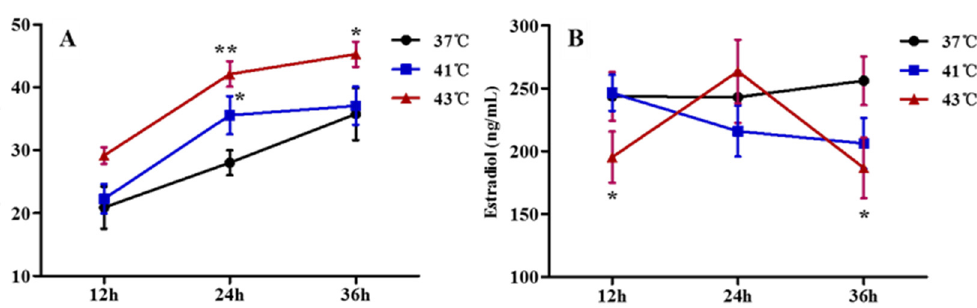
Figure 3. Effects of heat treatment on progesterone and estradiol synthesis in granulosa cells. Primary cultured GCs were kept at 37 °C, 41 °C and 43 °C for 12 h, 24 h, and 36 h, respectively. Progesterone ( A ) and estradiol ( B ) concentrations were analyzed using ELISA methods. * p < 0.05, ** p < 0.01.